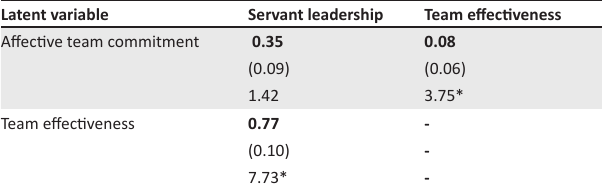
TABLE 3: The gamma and beta matrix of path coefficients for the structural model. Latent variable